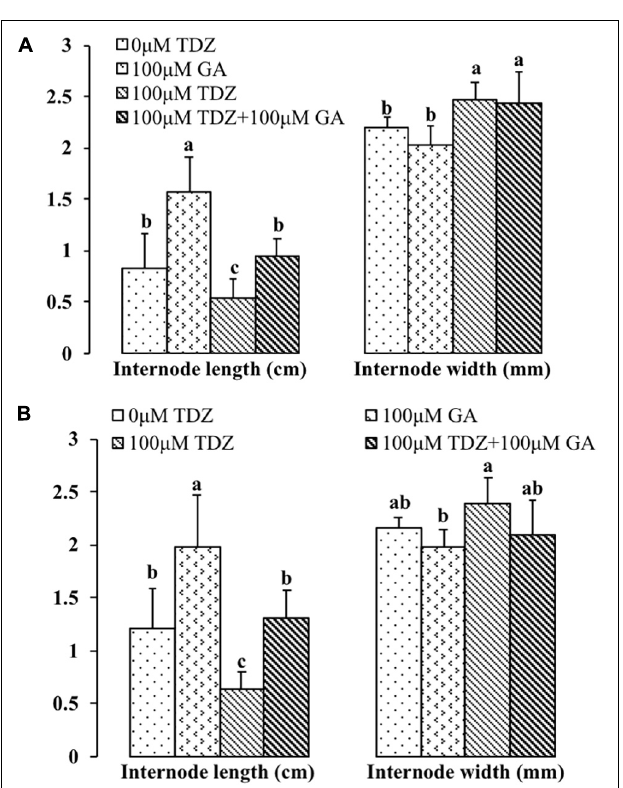
FIGURE 11 | Effects of 100 µ M TDZ and GA 3 spray treatments alone and together on the third (A) and fourth (B) internode length and thickness (width) of potted miniature rose plants for 2 weeks after the treatments. Means ( ± SE, n = 16) within length or thickness with different letters are significantly different at P ≤